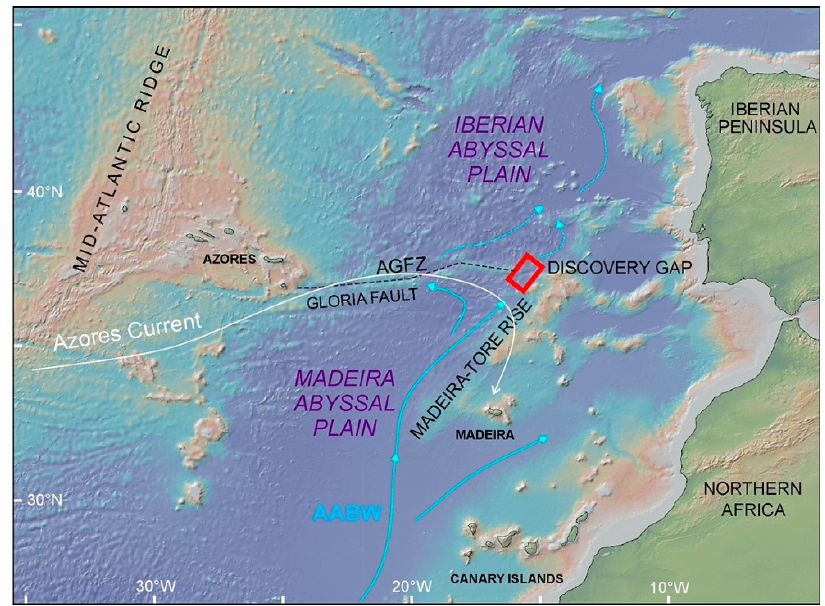
Figure 1. Study area and Antarctic Bottom Water (AABW) propagation in the NE Atlantic (blue arrows). The position of Discovery Gap is highlighted by a red square. AGFZ—Azores–Gibraltar Fracture Zone.